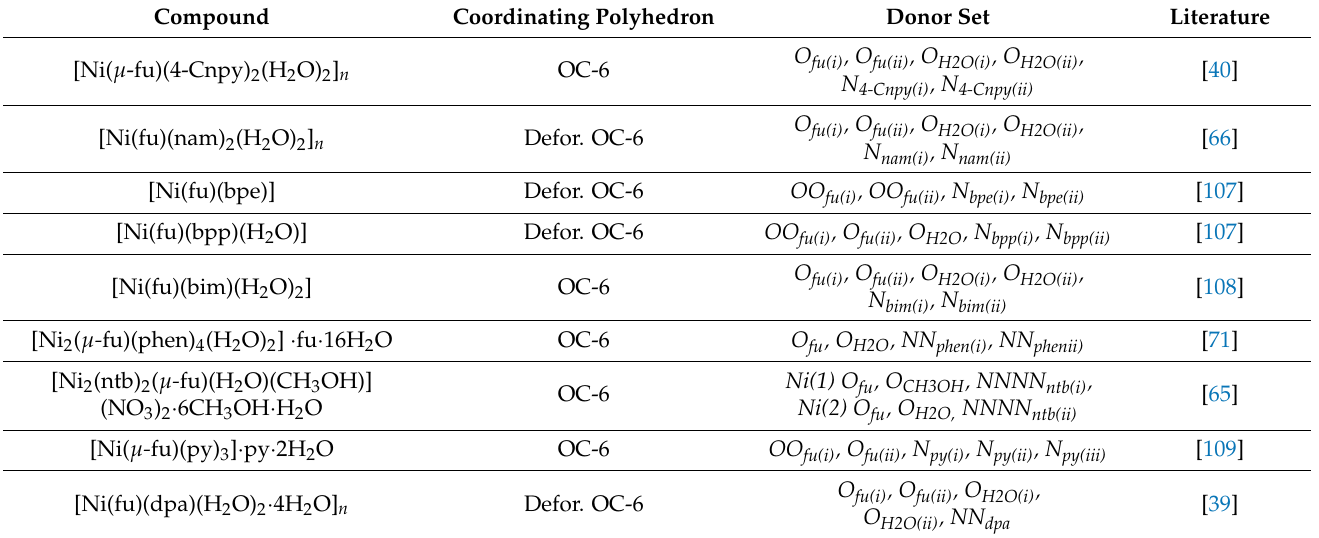
Table 9. Overview of nickel complexes prepared and structurally characterized with fumaric acid and N donor